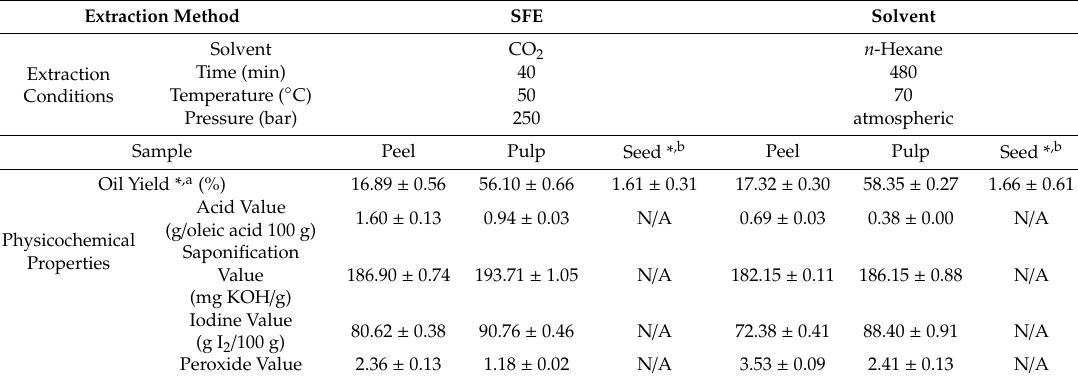
Table 1. Extraction conditions, oil yields and physicochemical properties (mean ± SD, n =